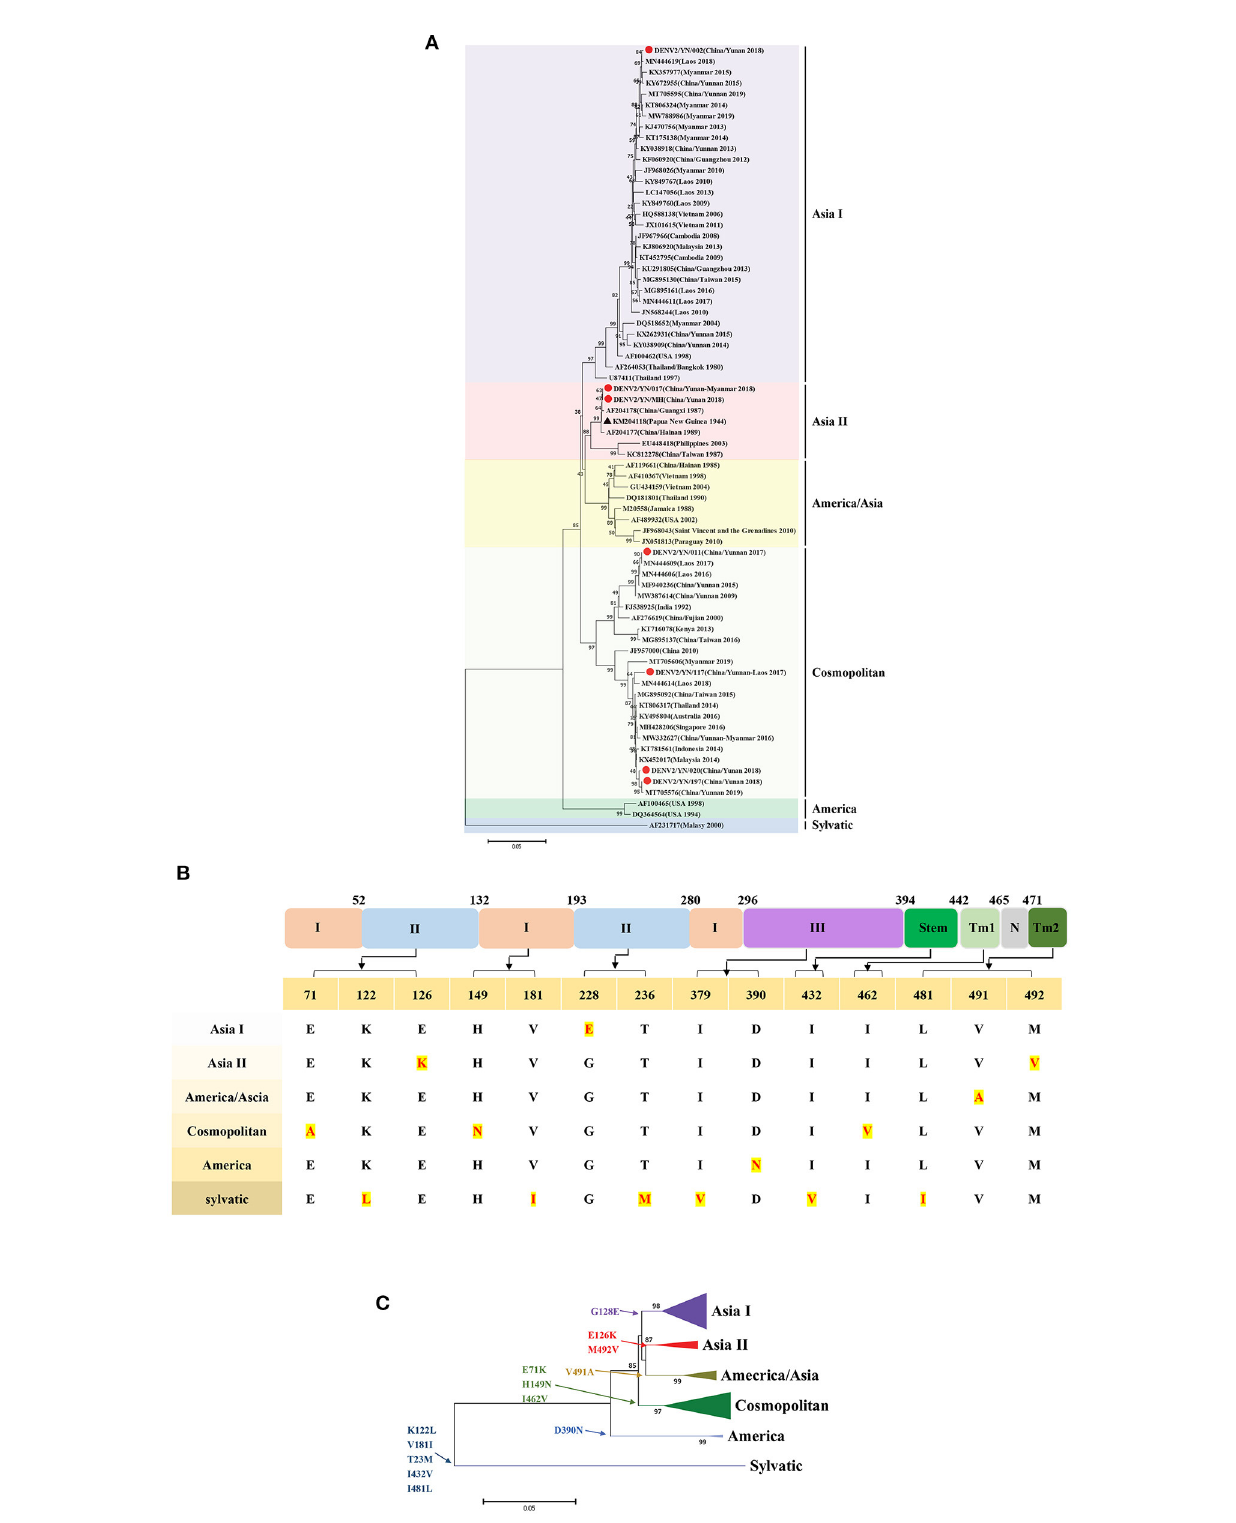
FIGURE4 (A) Phylogenetic tree of DENV-2 epidemic strains in Yunnan, China. The ML trees were built using 1,000 bootstrap replicates. The red circles indicate the strains detected in this study. (B) The characteristics of AA variations among different genotypes of DENV2. (C) Relationship between evolutionary tree branching and AA mutations in genotype I of